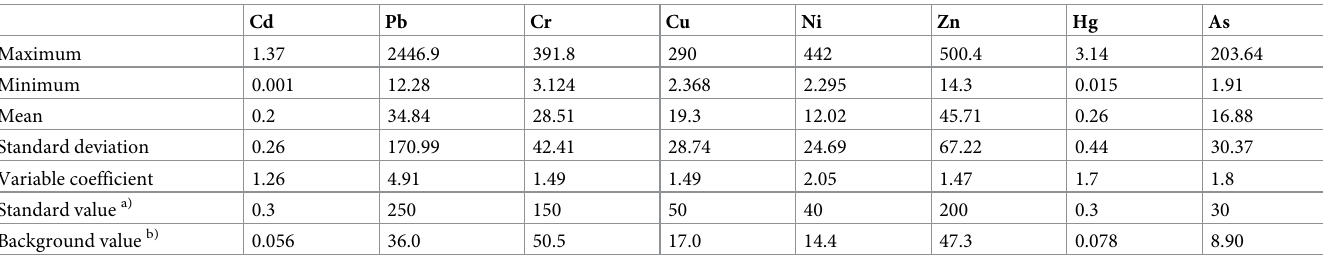
Table 1. A statistical summary of soil heavy metal content